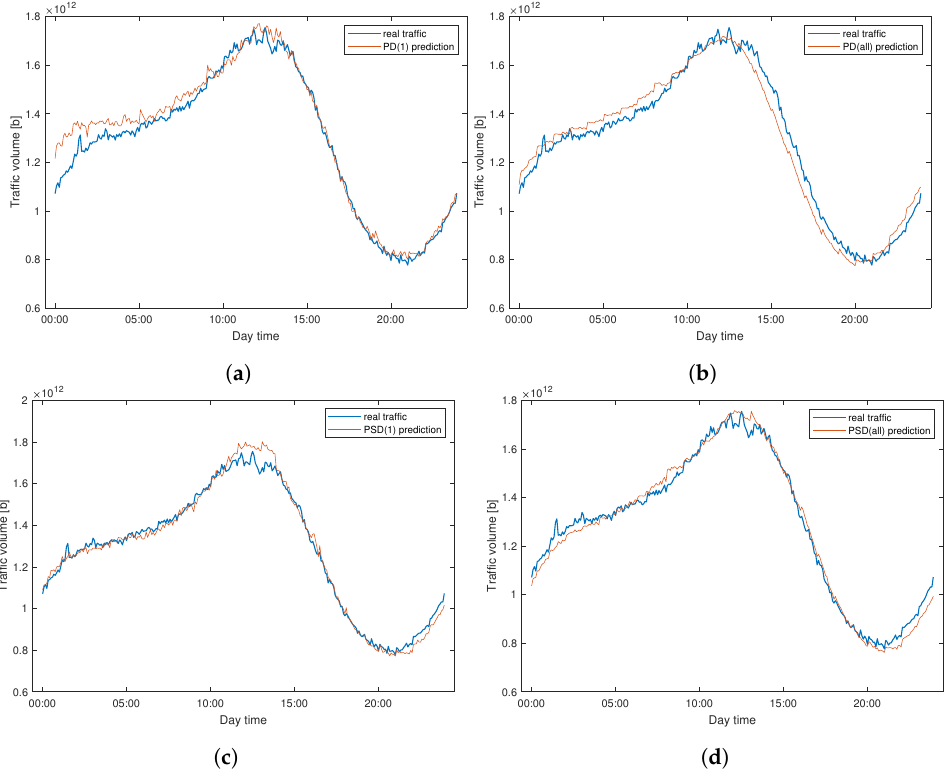
Figure 12. Efficiency of modeling-based prediction for SIX dataset—observed and predicted traffic as a time function. ( a ) PD (1) method, ( b ) PD (all) method, ( c ) PSD (1) method, ( d ) PSD (all)